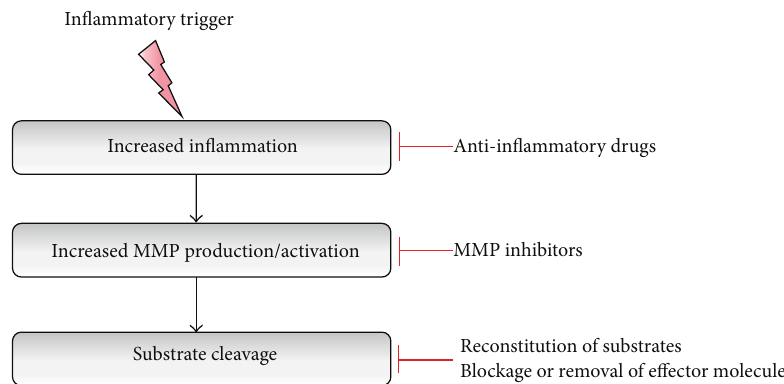
Figure 4: Strategies for targeting MMPs. Inflammatory triggers or protein aggregates in neurodegenerative diseases initiate an inflammatory cascade. At this early stage, various pharmacological anti-inflammatory drugs are effective in eliminating the downstream consequences. Increased inflammation induces and/or activates MMPs, and various broad spectrum inhibitors are available to inhibit MMPs. However, due to the fact that MMPs have both beneficial and detrimental effects, specific MMP inhibition might be a better approach. Finally, it is also possible to interfere at the level of the cleaved substrates, either by reconstitution of crucial substrates or by blockage or removal of effector